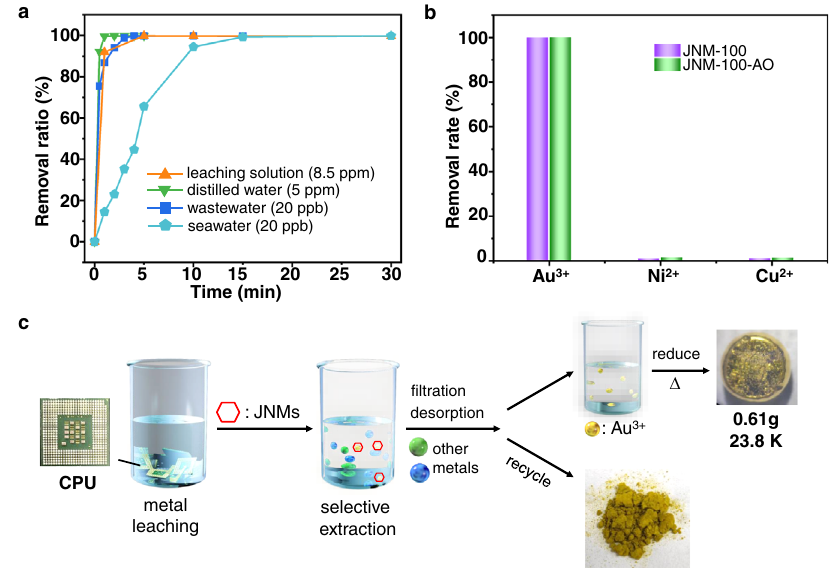
Fig.6|GoldrecoveryfromcomplexliquidsusingJNM-100-AO.a Theextraction rate of gold from complex liquids using JNM-100-AO. The complex liquids are e-waste leaching solution obtained from the CPU ( C 0 =8.5 ppm), orange line; dis- tilled water containing 5 ppm gold, green line; wastewater obtained from chicken